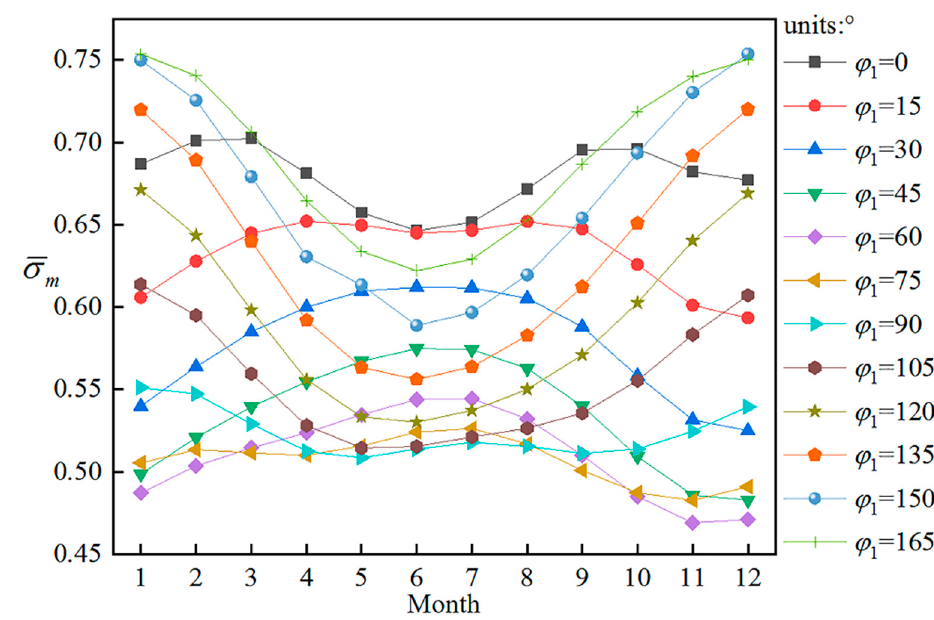
Figure 12. Variation of the monthly average effective tracking factor σ m of an SDC system under different azimuth axis tilt errors.